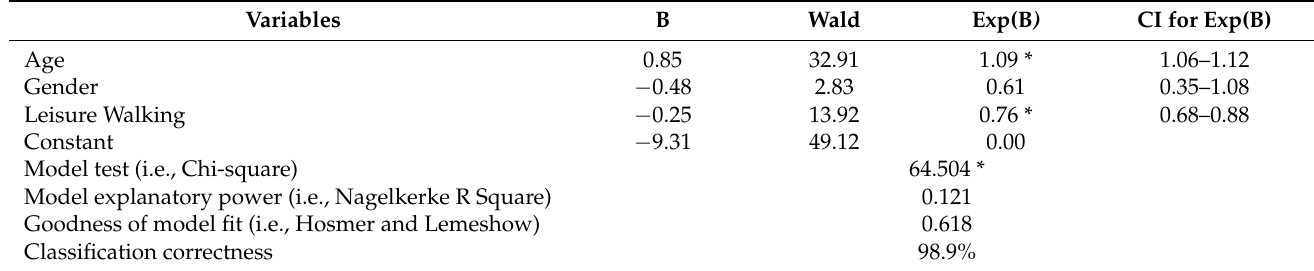
Table 3. Hierarchical Logit Regression for Alzheimer’s Disease.